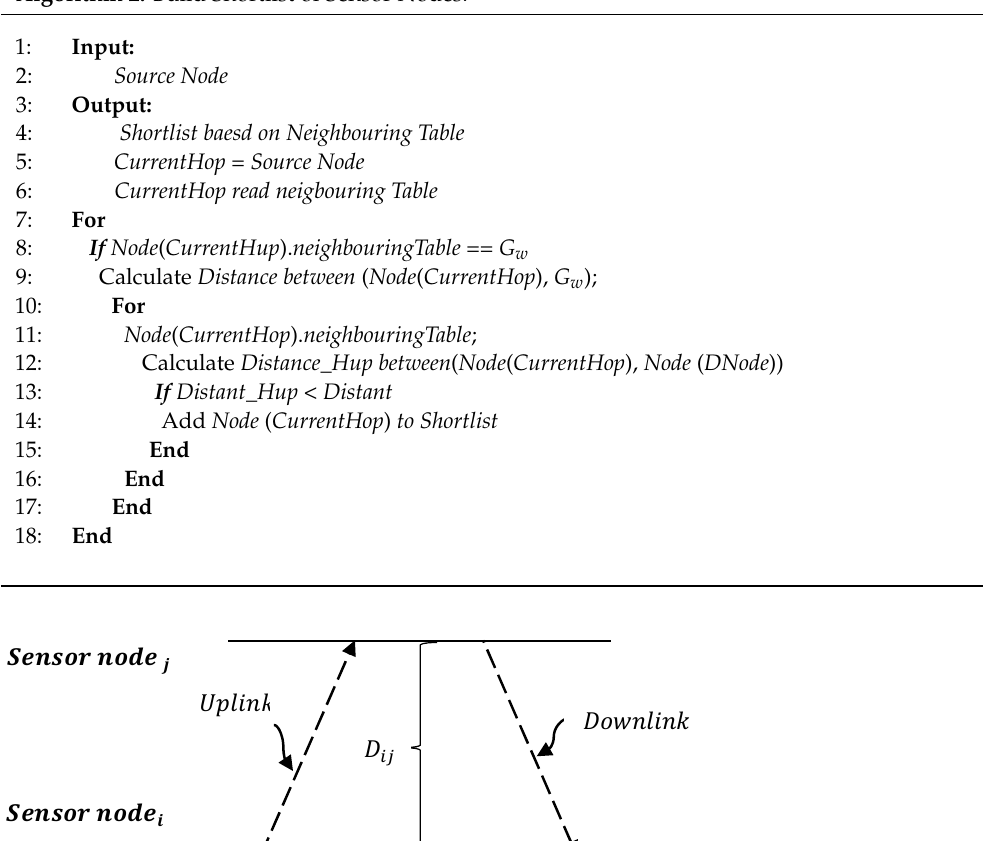
Algorithm 2: Build Shortlist of Sensor Nodes.